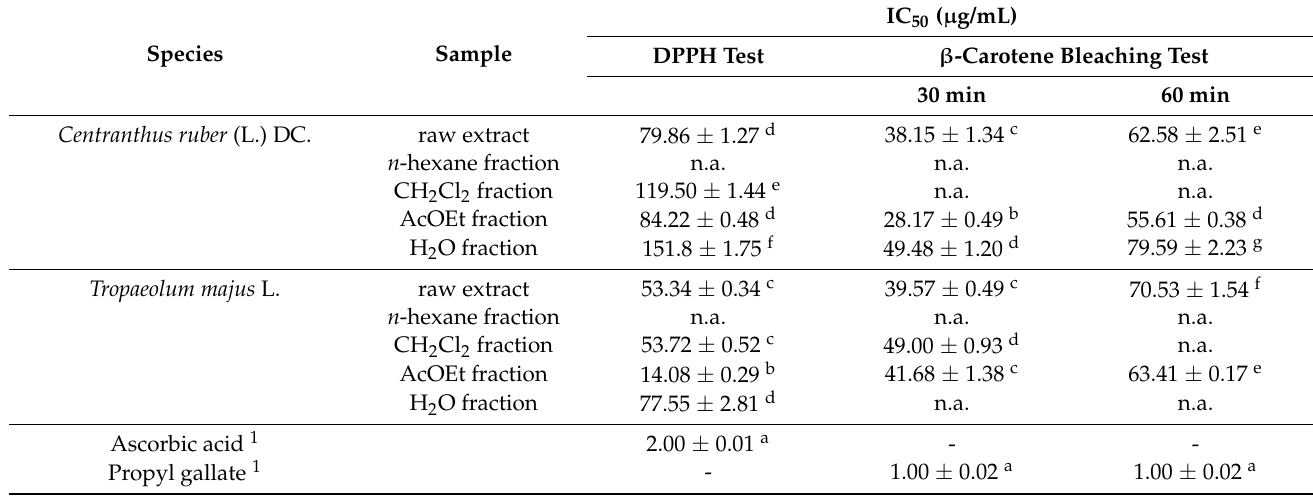
Table 3. Antioxidant activity of C. ruber (L.) DC. and T. majus L. extracts and fractions.